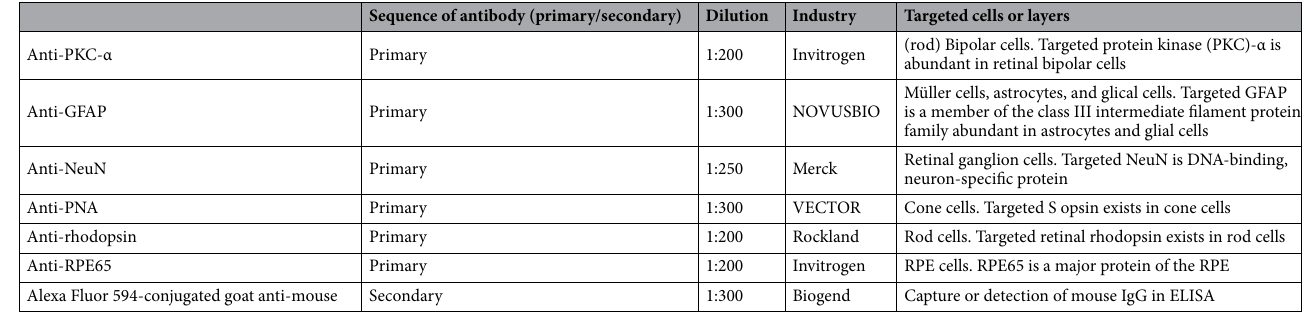
Table 4. Summary of immunohistochemistry for pig retinal degeneration model. PKC‑α Protein kinase-α, GFAP Glial fibrillary acidic protein, NeuN Neuron-specific nuclear protein, PNA peanut agglutin, RPE